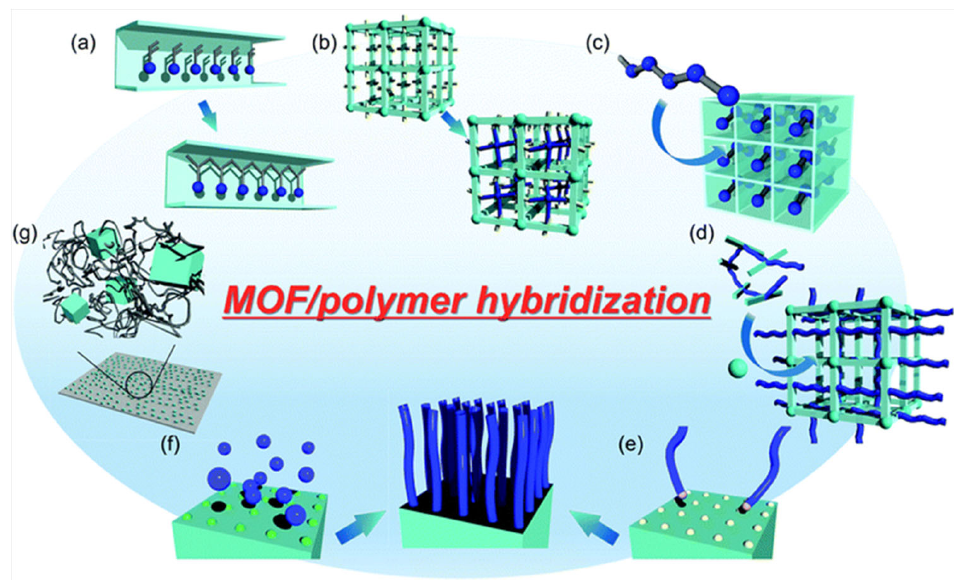
Figure 17. Different methodologies that can be used to synthesise MOF and polymer hybrids are shown. ( a ) Showing how the polymers can be made through polymerisations inside the nanochannels of MOFs. ( b ) Ligands being polymerised inside the pores of MOF. ( c ) Polymeric chains being introduced inside the nanochannels. ( d ) The polymers containing the ligands as their monomers. ( e ) Grafting polymer on MOFs and ( f ) grafting polymer from MOFs. ( g ) Mixed matrix membrane formation using polymer and MOFs. Reproduced with permission from [166] .